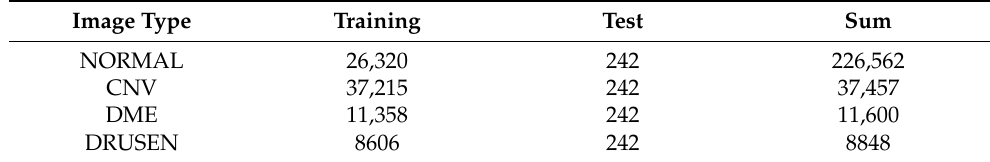
Table 4. Data settings of the UCSD